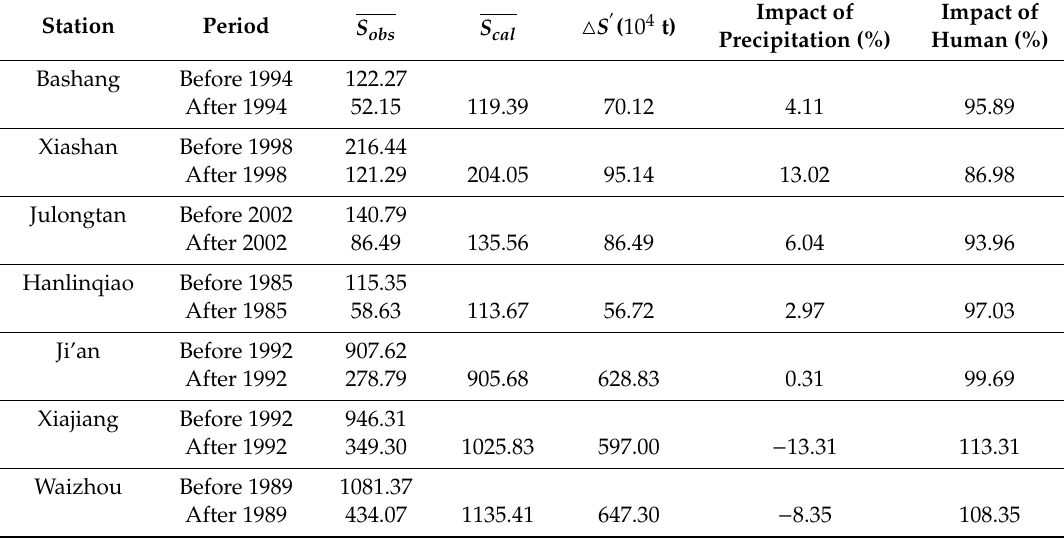
Table 5. Impact of precipitation and human intervention on sediment discharge decline after the change-point year at five stations in Ganjiang